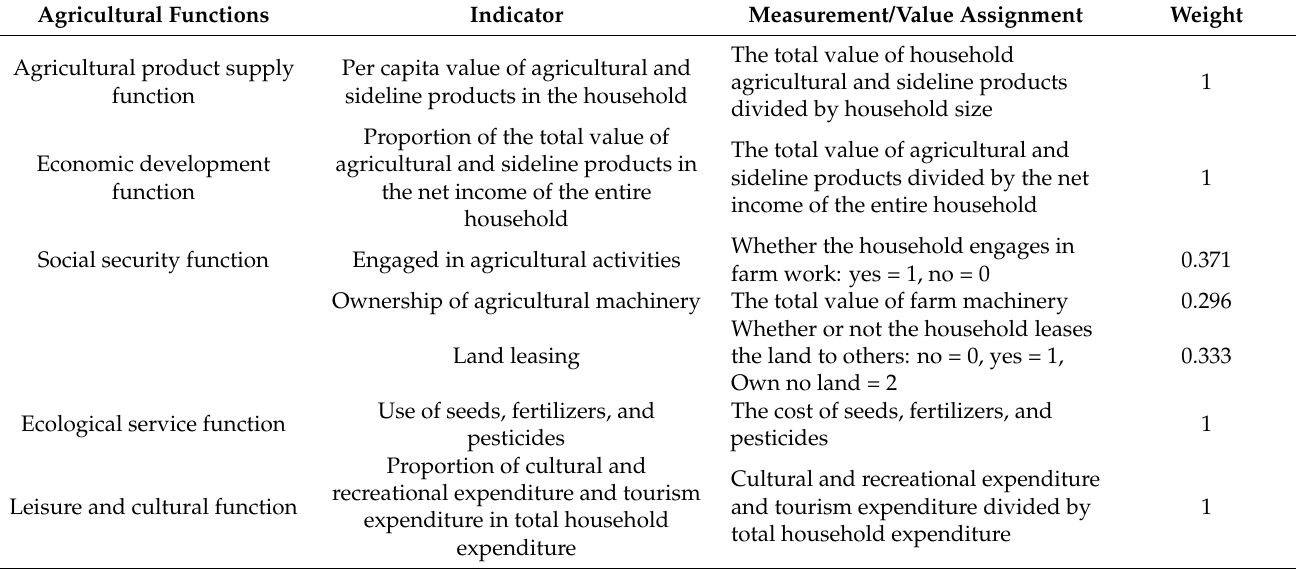
Table 3. Agricultural function evaluation index